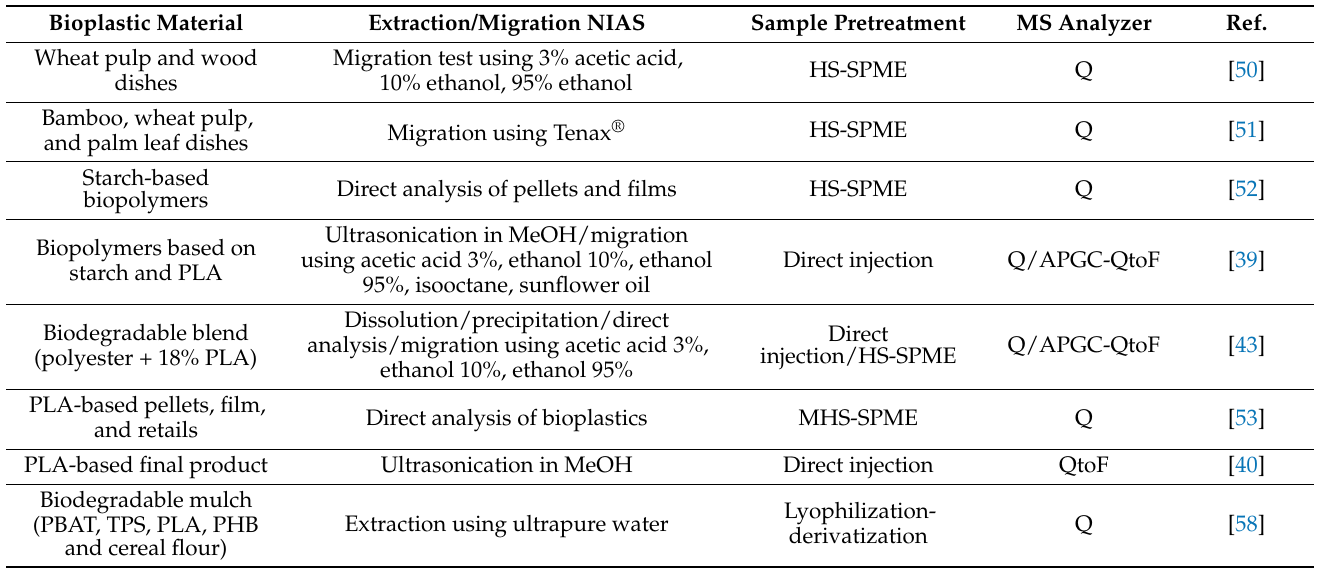
Table 1. GC-MS methods for the investigation of volatile and semi-volatile NIAS in